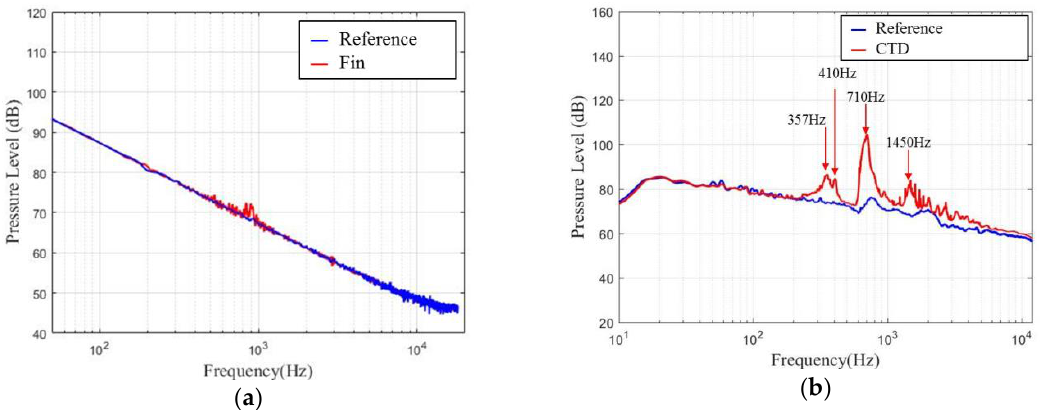
Figure 6. Measurement noise levels during underwater glider operation at sea: ( a ) Fin, and ( b ) Pumped Conductivity-Temperature-Depth profiler (CTD).